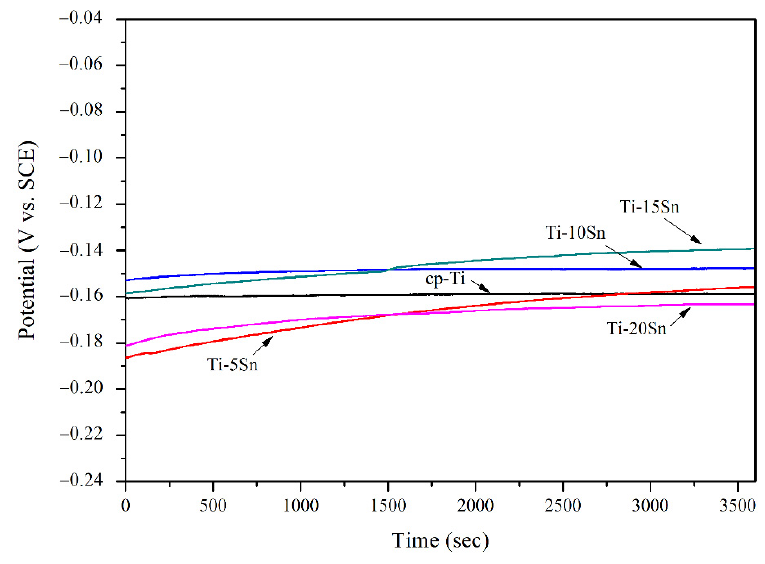
Figure 4. The open circuit potential curves of cp-Ti and Ti-Sn alloys in 0.9% NaCl solution at 37 °C.